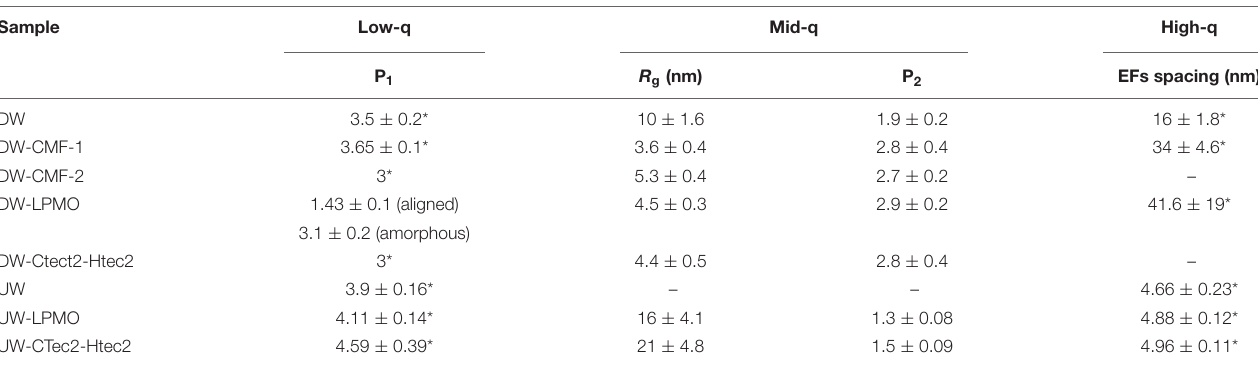
* Parameters were fitted using the anisotropic curve and fixed while fitting the amorphous curve. ** Parameters were fixed while fitting the isotropic curves due to weak features and/or limited q-range. TABLE 5 | Impact of pre-delignification on CMF and enzymatic treatments.